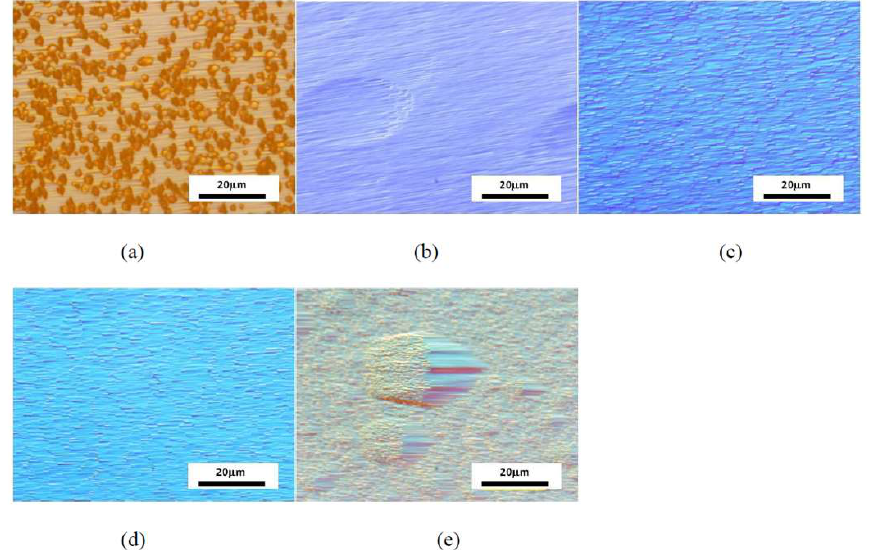
Figure 1. Nomarski images of InGaN layers with different In contents grown on the {11-22} GaN templates at ( a ) 700, ( b ) 750, ( c ) 775, ( d ) 800, and ( e ) 850 °C.